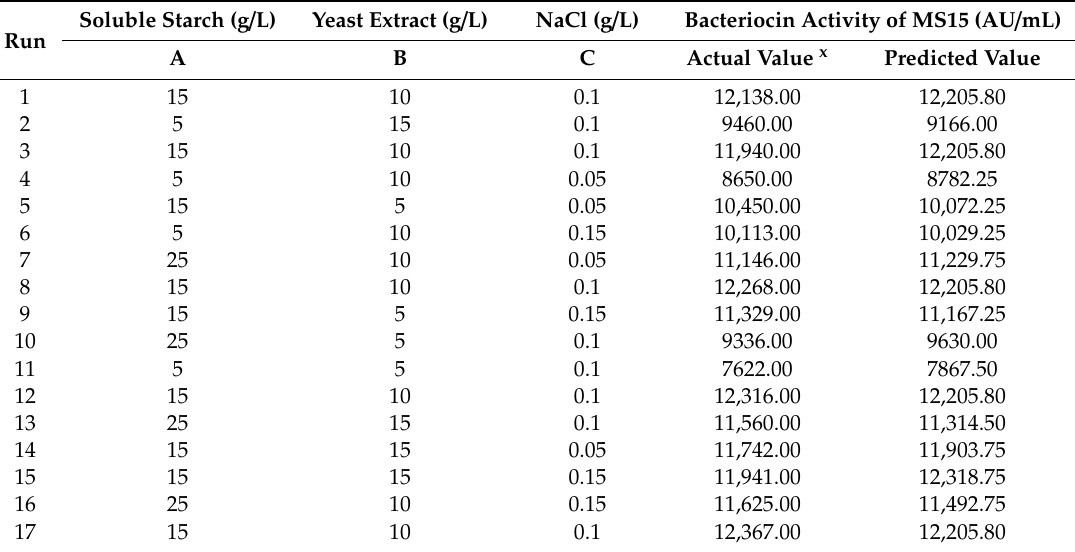
Table 2. Assessment of the generated data by the Box-Behnken